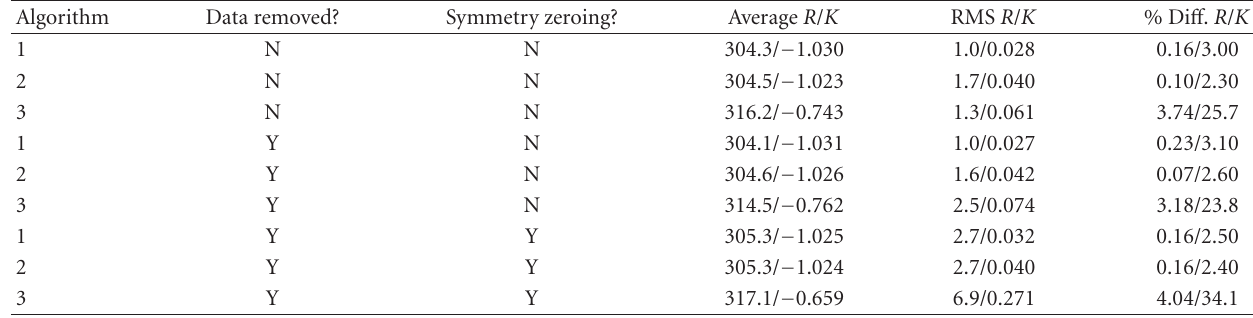
Table 1: Results of